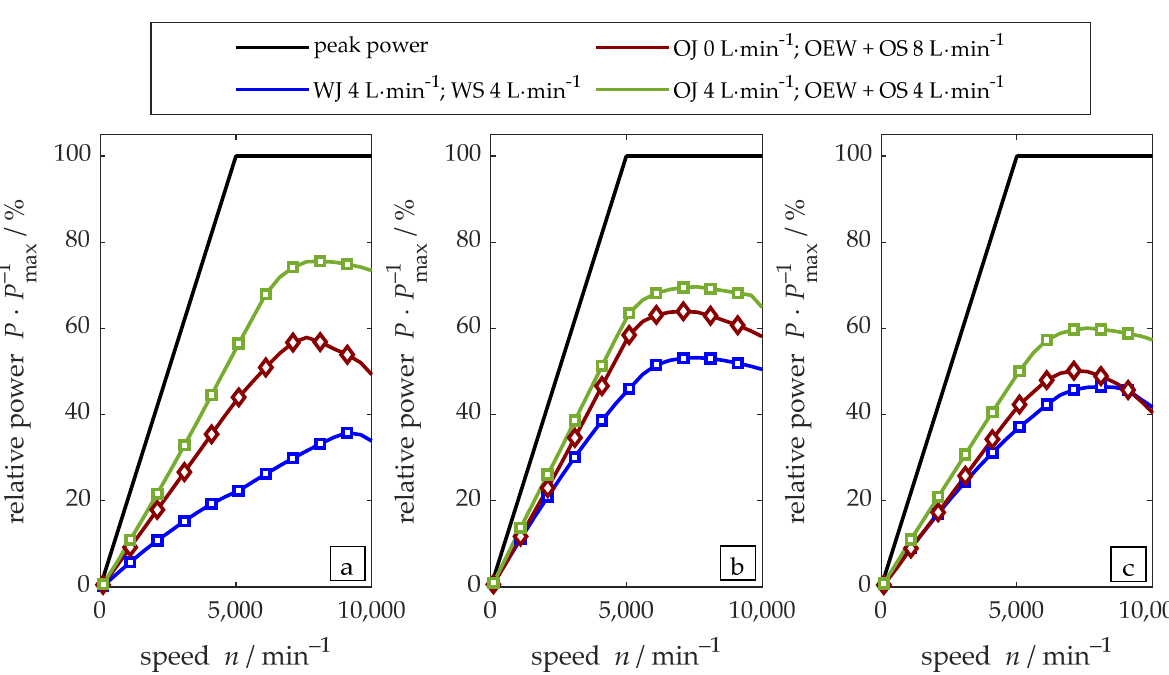
Figure 9. Comparison between of the relative continuous power of three different cooling topologies for different machine lengths: ( a ) L EM = 0.5 · L ref , 100 kW performance category, ( b ) L EM = L ref , 200 kW performance category and ( c ) L EM = 1.5 · L ref , 300 kW performance category. Topologies have the same overall volume flow rate but different distributions between water/oil stator jacket (WS/OJ), shaft (WS/OS) and end winding cooling (OEW).